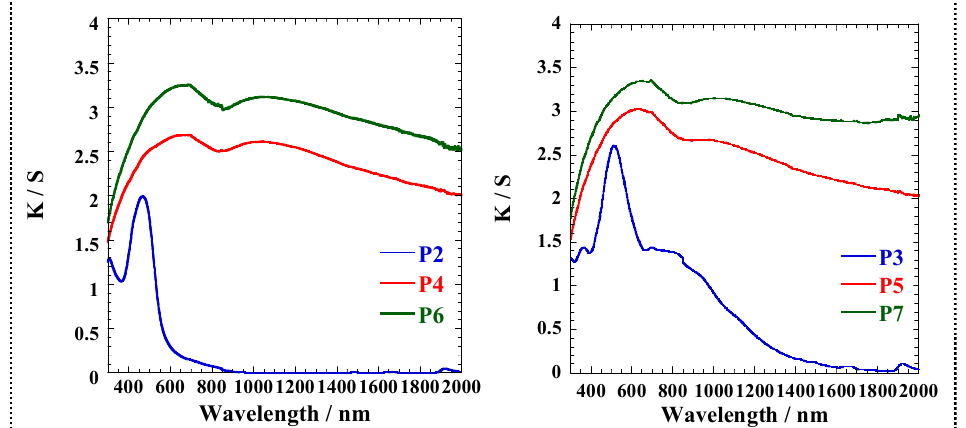
Figure 3. UV-Vis-NIR spectra of P2 – P7 transformed by using diffuse reflection spectra.